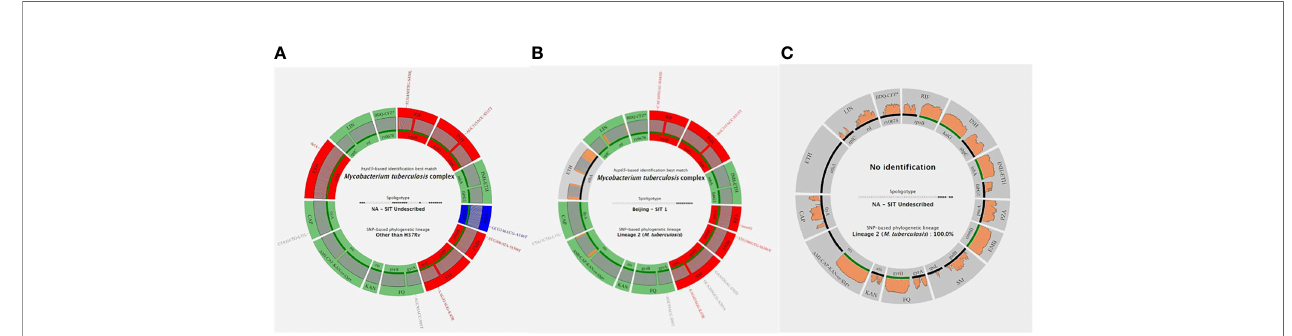
FIGURE 1 | Three examples of Deeplex Myc-TB results. (A) Successful Deeplex Myc-TB result. (B) Successful Deeplex Myc-TB result with deletion in ethA . (C) Failed Deeplex Myc-TB result. hsp65 -based identi fi cation best match, spoligotype, and SNP-based lineage identi fi cation are shown in the center of the map. Targeted loci are displayed in groups, depending on which antibiotic(s) they impact: rpoB for rifampicin (RIF); katG-ahpC for isoniazid (INH); inhA-fabG1 for INH and ethionamide (ETH); pncA for pyrazinamide (PZA); embB for ethambutol (EMB); rpsL-gidB for streptomycin (SM); gyrA-gyrB for fl uoroquinolones (FQ); eis for kanamycin (KAN); rrs for amikacin, capreomycin, and kanamycin (AMI-CAP-KAN); tlyA for CAP, ethA for ETH, rplC-rrl for linezolid (LNZ); and rv0678 for bedaquiline- clofazimine (BDQ-CFZ). Wild-type alleles are shown in green, mutant alleles with mutations linked to resistance in red, and uncharacterized variants in blue (dark blue if the SNV is fi xed, light blue if the SNV is un fi xed). Gray color indicates that more than 5% of the locus is missing (e.g., in ethA in B ). Sequencing depths are indicated above the circle representing the ampli fi ed genes, colored in gray if the read depth is >100× on average, and in orange if the read depth is <100× on average. Filled lines shown above the loci names are colored according to the ampli fi cation ef fi ciency of each gene: green if >95% of the locus has been sequenced, and black if <95% of the locus has been sequenced. Each variant is noted with the reference codon, codon number, and the alternate codon, followed by the reference amino acid, amino acid position, and the mutated amino